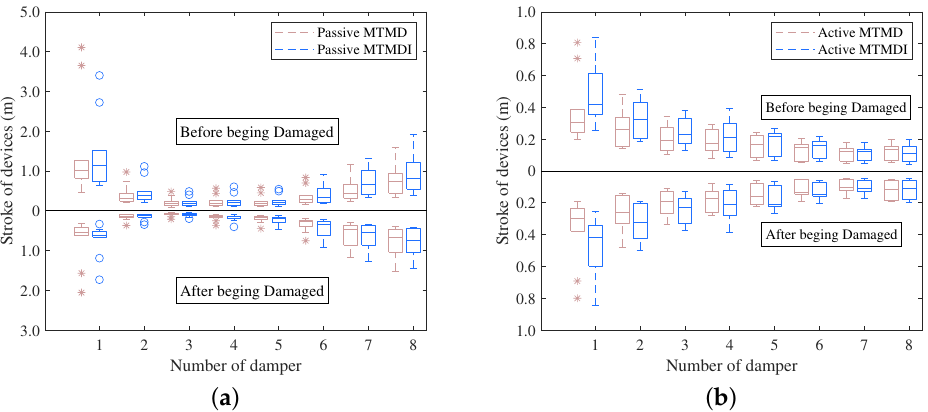
Figure 21. The statistics value for the stroke of different DVAs: ( a ) Passive control and ( b ) Active